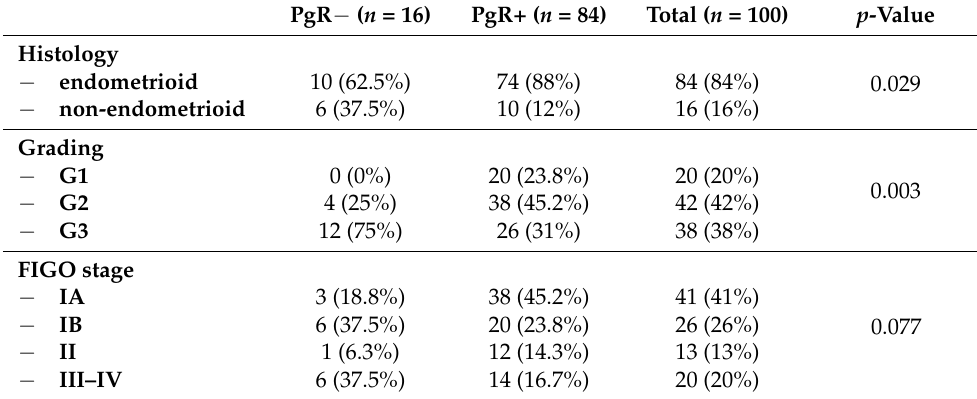
Table 4. Progesterone receptor (PgR) status and histopathological features.